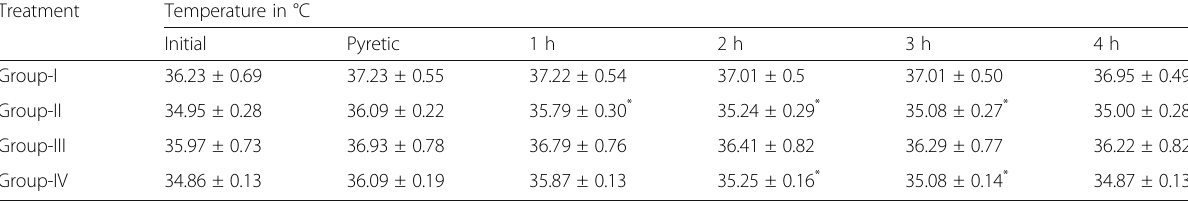
Table 6 Effect of methanol extract of L. sativus L. seeds on 2, 4-Dinitrophenol (DNP) induced pyrexia in mice